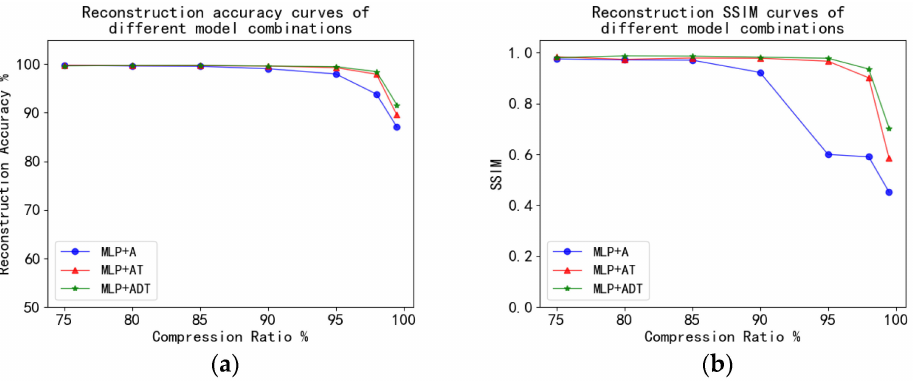
Figure 2. ( a ) Reconstruction accuracy curves of different model combinations; ( b ) Reconstruction SSIM curves of different model